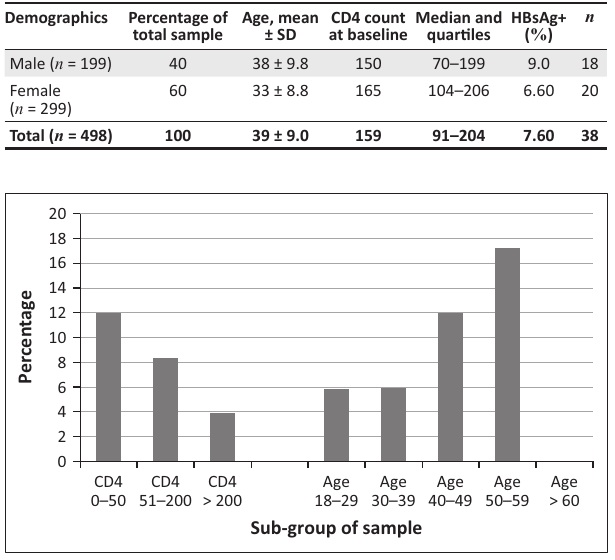
FIGURE 1: Hepatitis B surface antigen positivity for different CD4 counts and age groups in the study